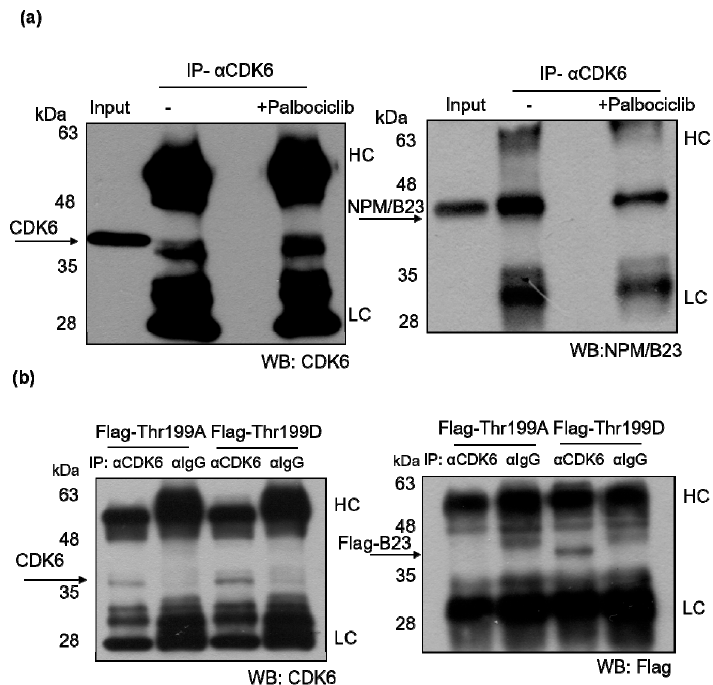
Figure 6. Phosphorylated NPM/B23 (Thr199) is capable of associating with CDK6. ( a ) ARK2 were treated with 2 µM palbociclib for 24 h (at the experimental conditions described in the Methods section). Whole-cell lysates were immunoprecipitated (IP) with an anti-CDK6 antibody ( α -CDK6) and subsequently analyzed by immunoblotting with an anti-CDK6 antibody or an anti-NPM/B23 antibody. ( b ) ARK2 cells were transfected with the dephospho-mimetic NPM/B23 mutant (Thr199A) or the phospho-mimetic NPM/B23 mutant (Thr199D) for 24 h and immunoprecipitated (IP) with an